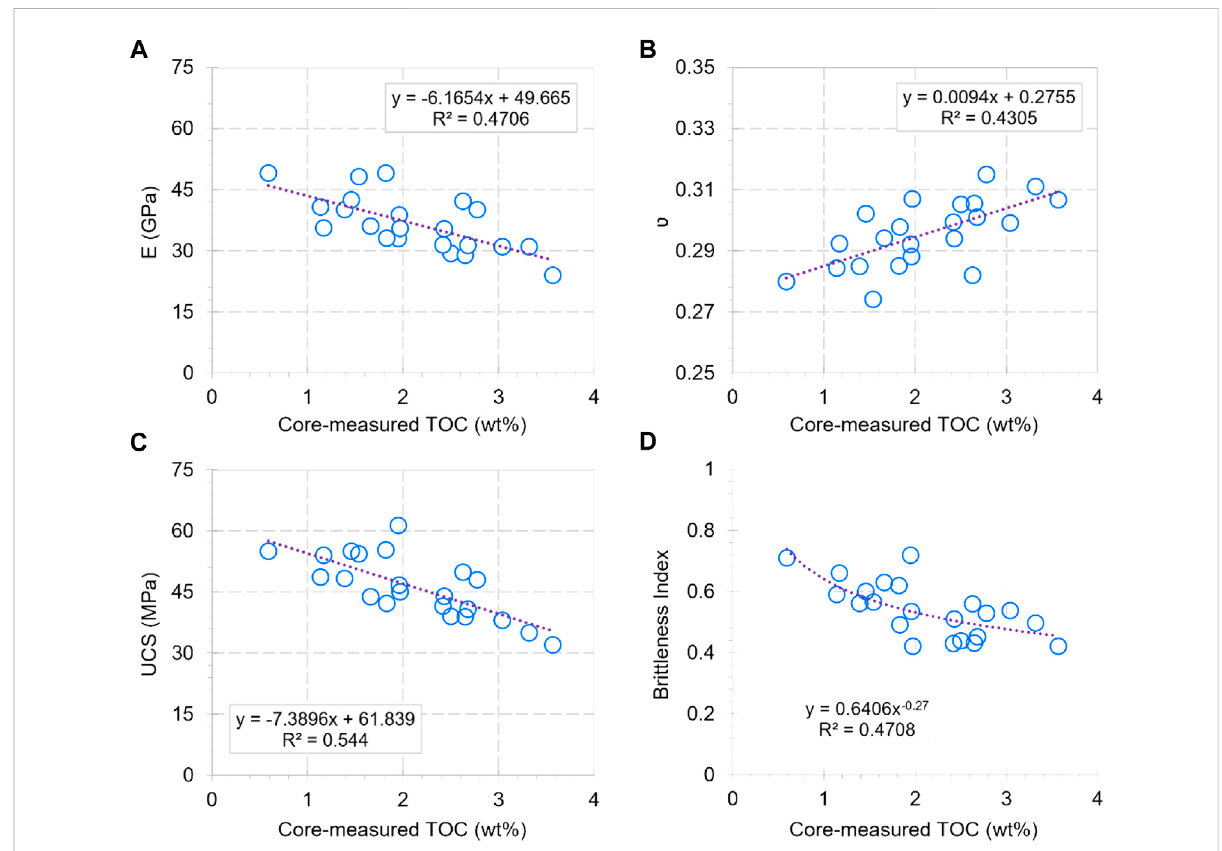
FIGURE 4 Relationship of core-measured TOC with (A) Young ’ s modulus, (B) Poisson ’ s ratio, (C) UCS and (D) brittleness